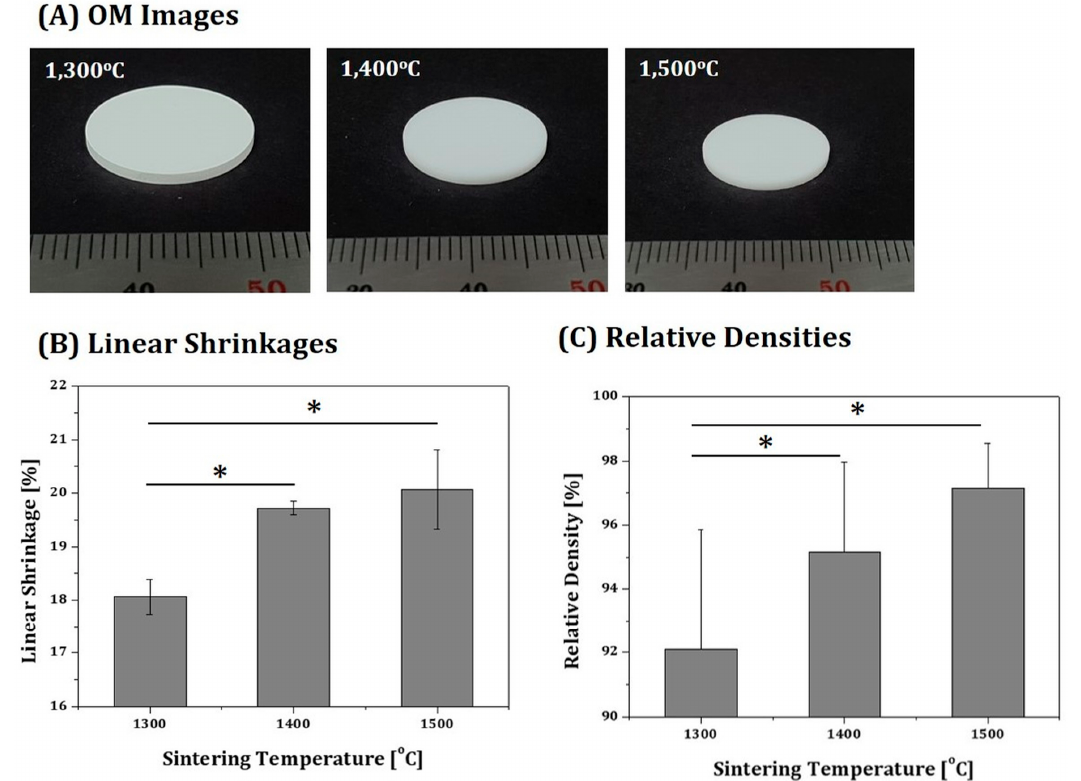
Figure 9. ( A ) Optical images of 4Y-PSZ disks sintered at various temperatures (1300 ◦ C, 1400 ◦ C, and 1500 ◦ C) for 3 h (scale = 1 mm), and their corresponding ( B ) sintering shrinkages (* p < 0.05) and ( C ) relative densities (* p < 0.05).